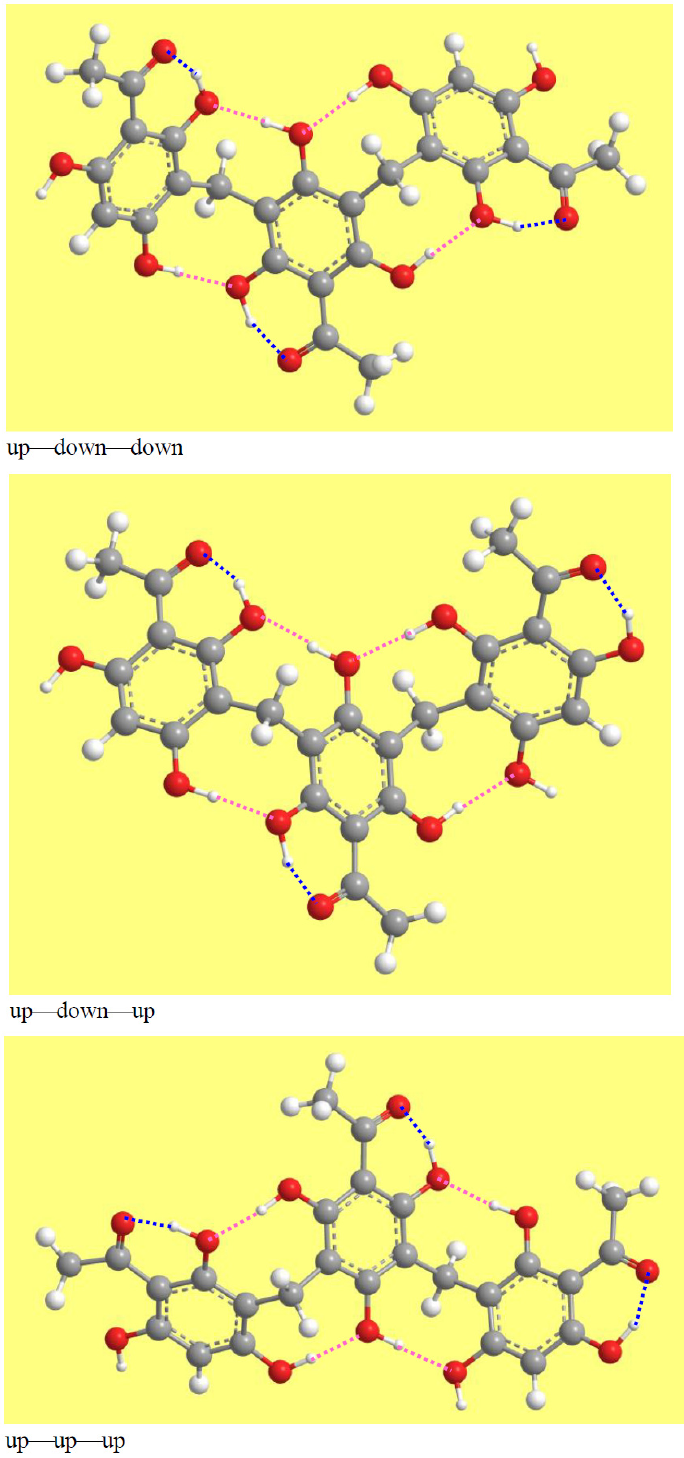
Figure 8. Intramolecular hydrogen bonds (IHBs) in trimeric acylphloroglucinols. The first IHBs of individual monomers are denoted by blue dashed segments and the hydrogen bonds between monomers by purple dashed segments. The three lowest energy conformers of T1 (all with the O8–H15 ··· O14 first IHB in the first monomer) are utilised to illustrate the three different combinations of monomers’ orientations and some of the resulting possible IHB and IHB-cooperativity patterns.